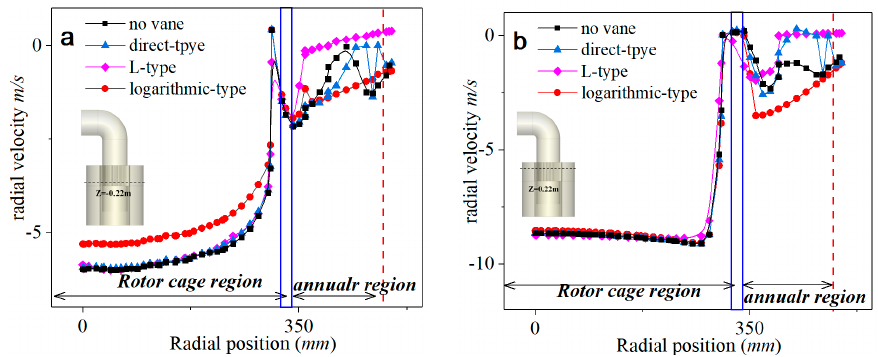
Figure 8. Comparison of the radial velocity distribution of rotor cage by four different guide vanes in two sections ( a ) Z = 0–0.22 m, ( b ) Z = 0.22